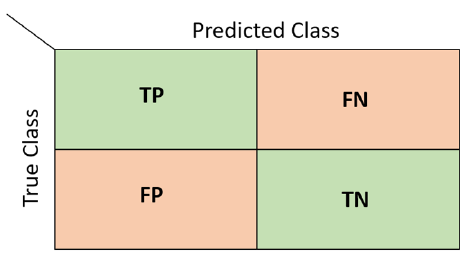
Figure 11. A two-class confusion matrix.